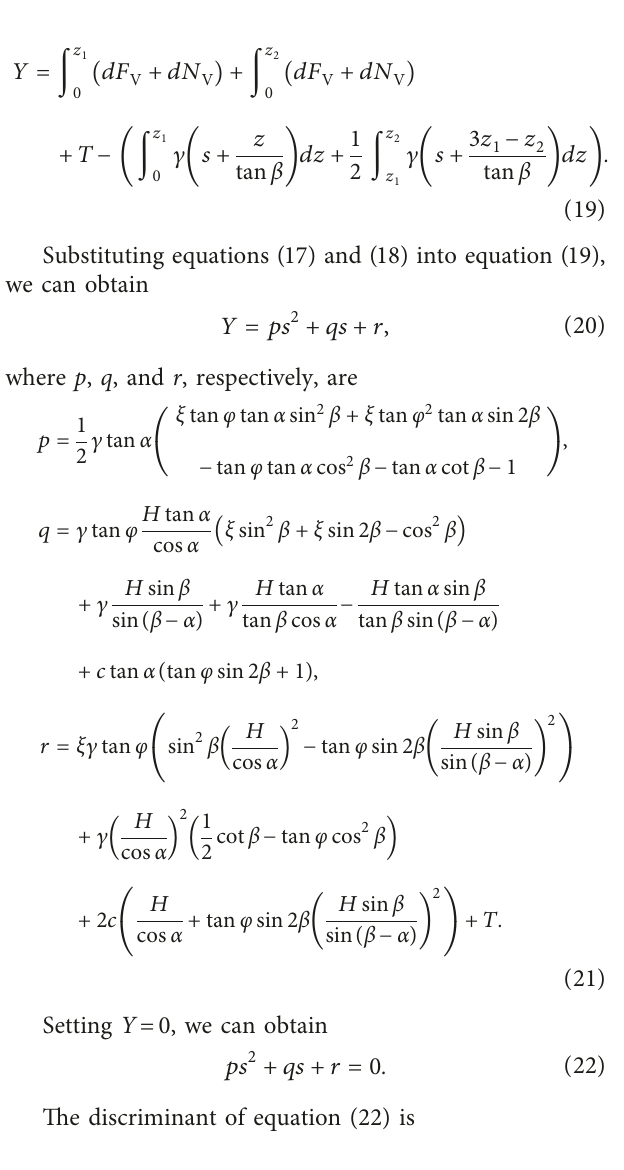
Figure 3: Stress analysis of thin-layer